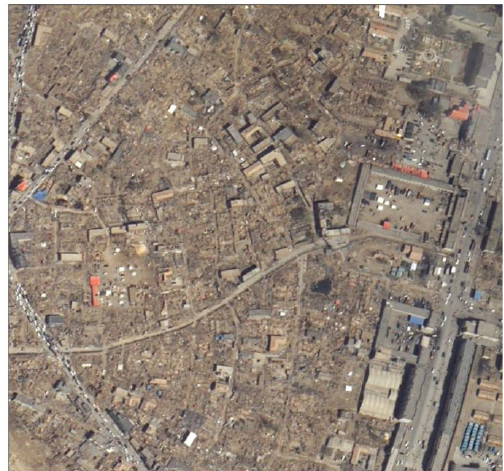
Figure 6: post-earthquake airborne image of Gyêgu town